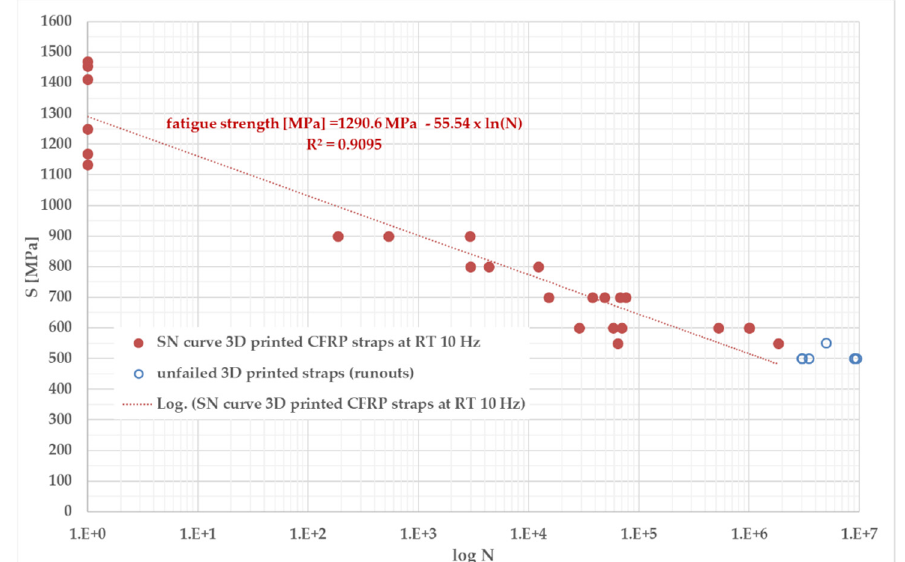
Figure 10. S – N curve for Ti64 pin-loaded CFRP straps, showing the upper stress level S in function of endured load cycles N in logarithmic scale.